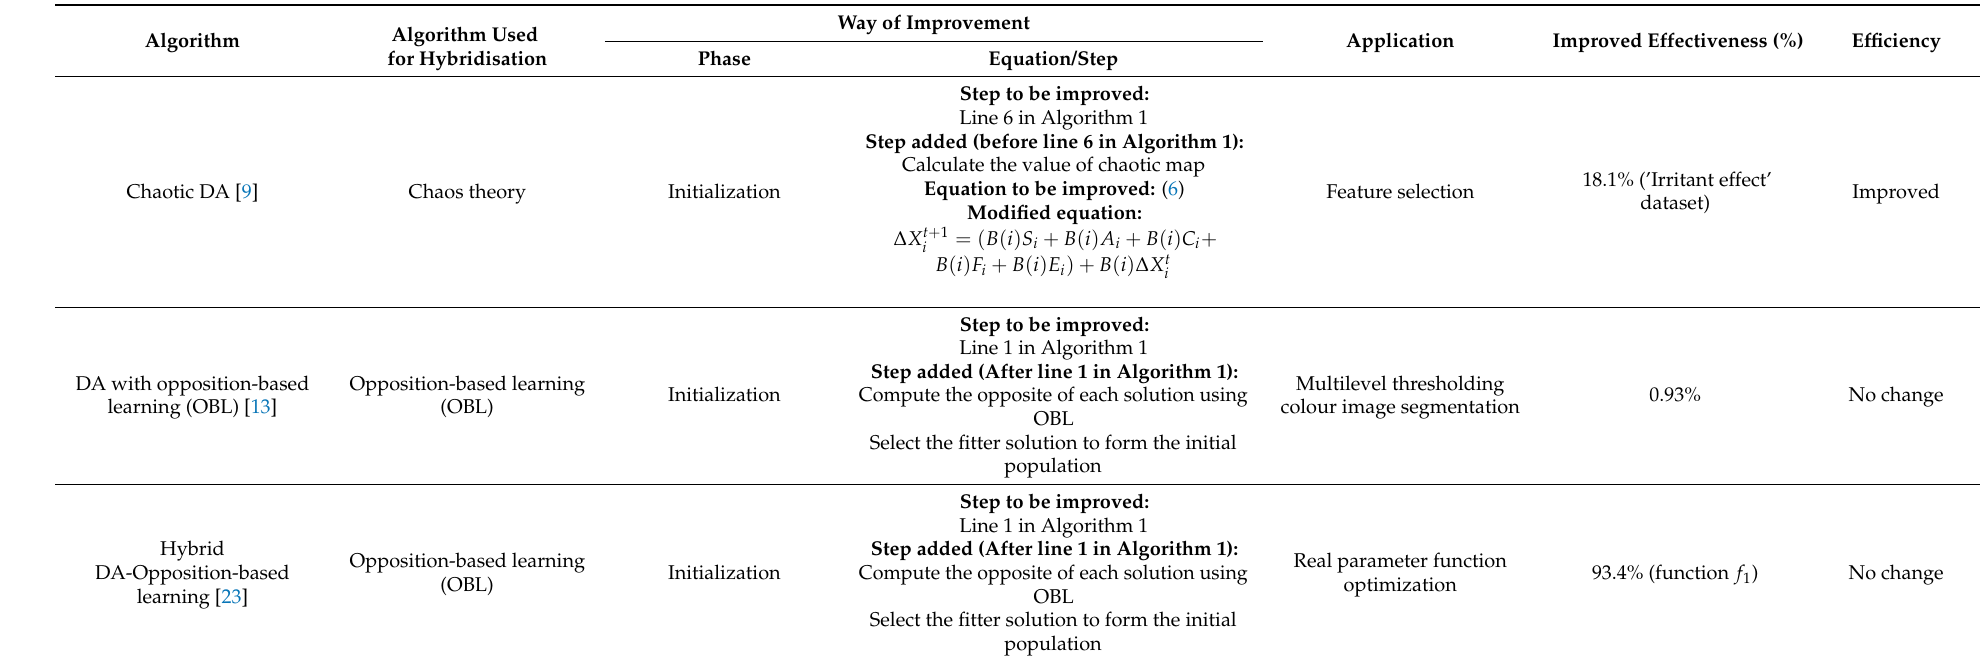
Table 5. Hybrids of DA which improve its effectiveness by improving